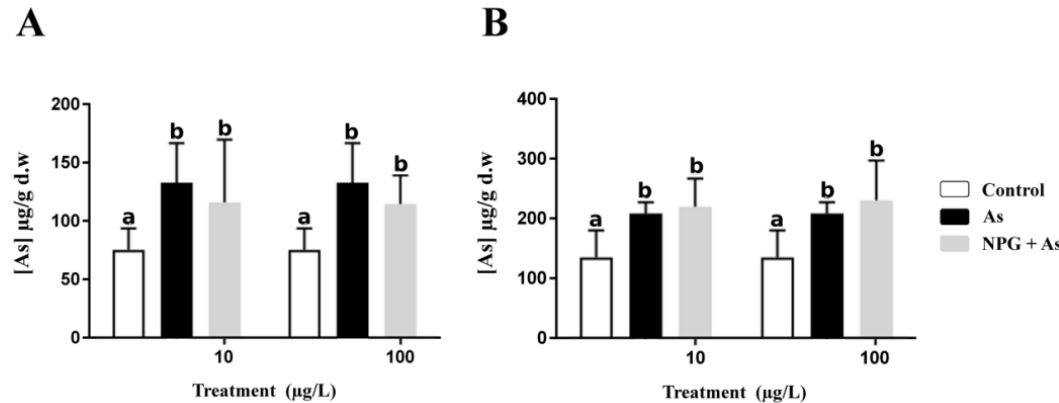
Figure 3. Arsenic accumulation in gills ( A ) and visceral mass ( B ) ( µ g g − 1 dry weight, mean + sd), after one week of exposure to 0 (Control) and 1 mg L − 1 of As alone or combined with NPG (10 and 100 µ g L − 1 ). Different letters denote statistical differences between treatments assessed by two-way ANOVA followed by Bonferonni post-hoc test ( n = 4); p < 0.05.